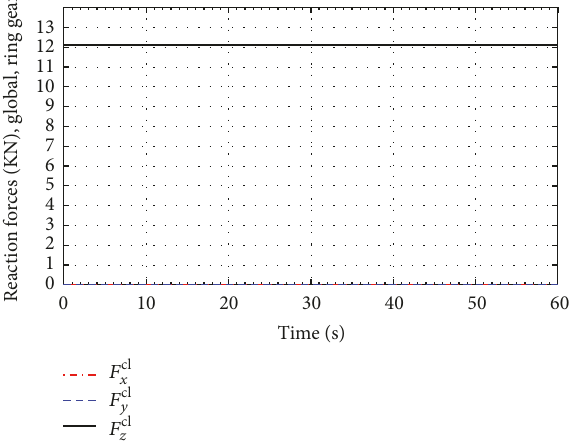
Figure 11: Reaction forces in global coordinates of ring gear.